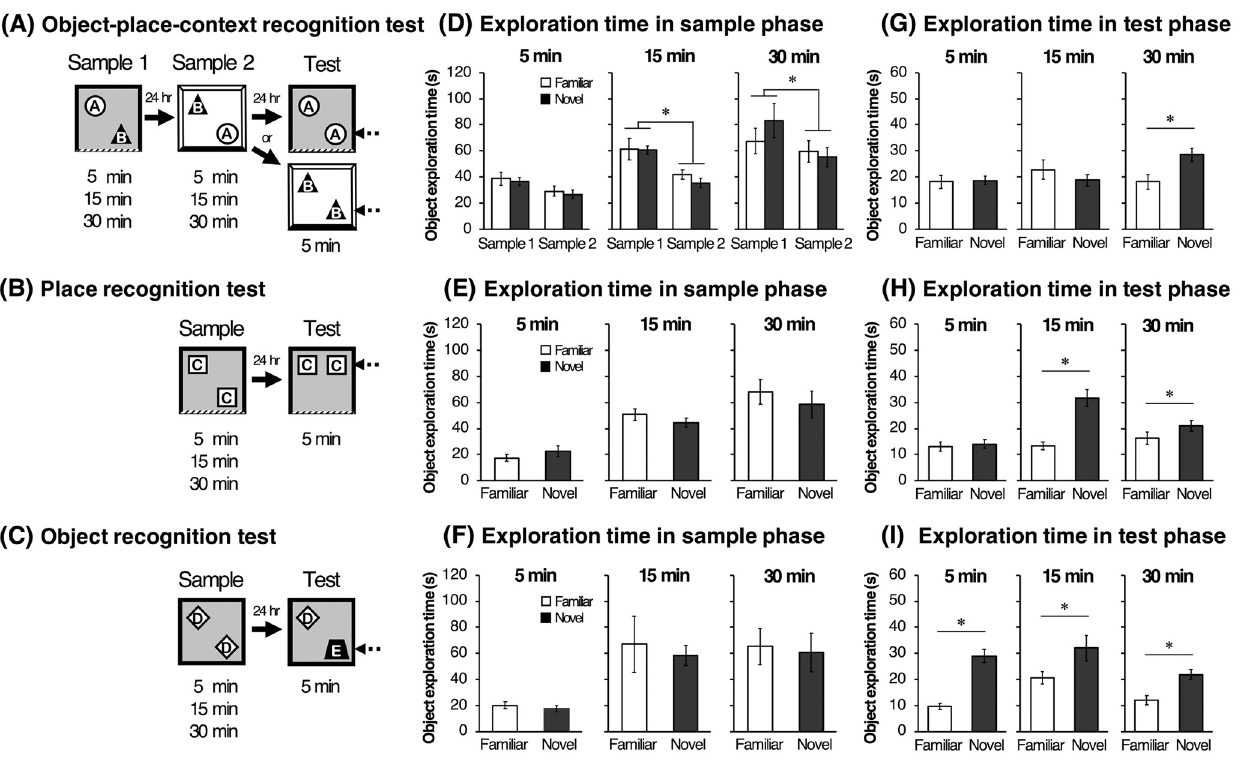
Fig 1. Schematic illustrations of object-place-context (OPC) recognition test (A), place recognition test (B), and object recognition test (C). Each test consists of sample phase (5, 15 or 30 min), retention interval (24 hours), and test phase (5 min). A successful discrimination is defined as a preferential exploration of the ‘object in a novel context-place combination’ in OPC recognition test, ‘the object in a novel location’ in place recognition test or ‘the novel object’ in object recognition test and is indicated by dashed arrows. Mean ( ± SEM) time spent in exploration for each object in sample phase of OPC recognition test (D), place recognition test (E), and object recognition test (F). Mean ( ± SEM) time spent in exploration for each object in test phase of OPC recognition test (G), place recognition test (H), and object recognition test (I). A two-way (Phase × Object) ANOVA followed by a post-hoc Scheffe test was used for the analysis of the exploration time in sample phases of OPC recognition test. A paired Student’s t-test was used for comparison between familiar and novel objects. � p <